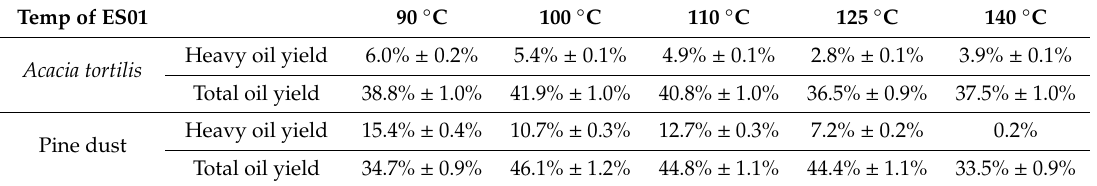
Table 3. Actual yield of primary condensate at various primary condenser temperatures. Temp of